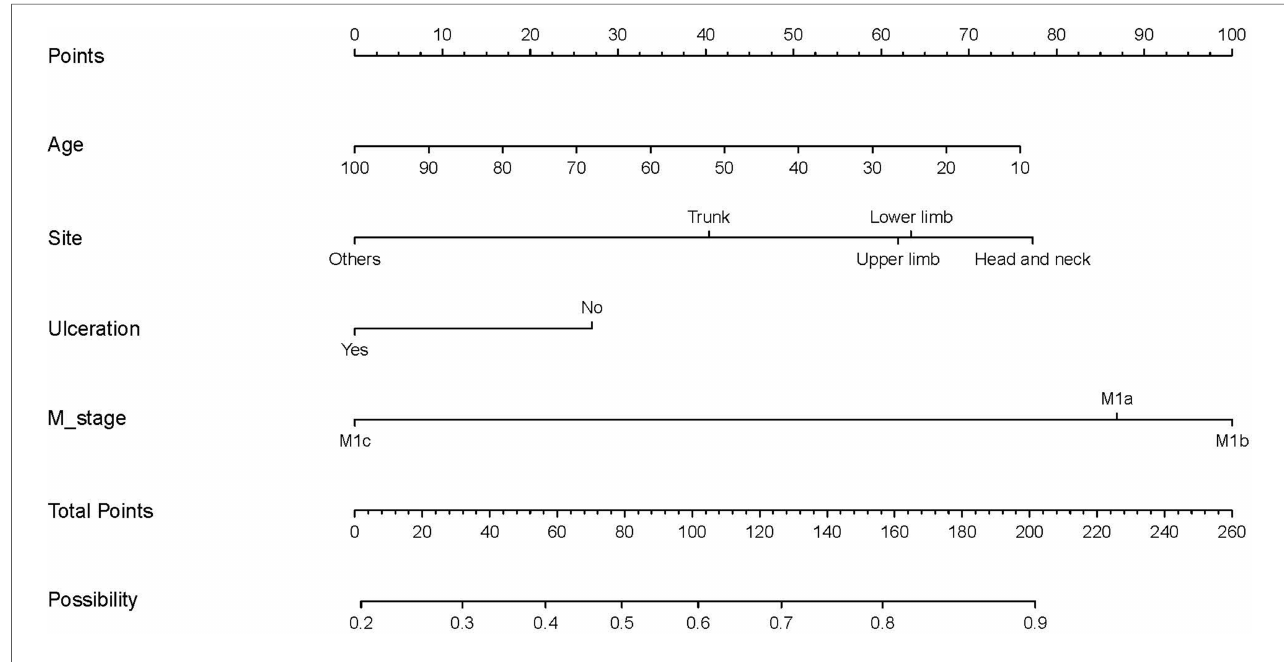
FIGURE 3 A nomogram to predict optimal candidates for primary tumor resection.